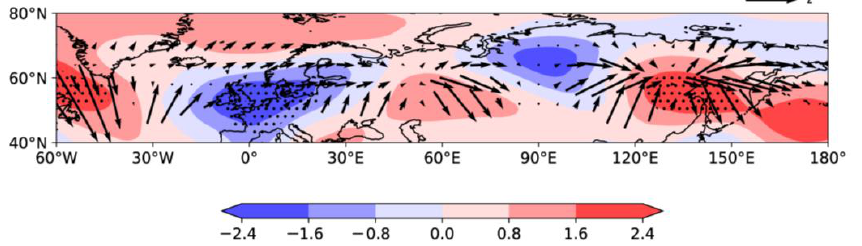
Figure 12. Composite summer geopotential height at 200 hPa (shading, units: dagpm) and Plumb wave activity fluxes (vector, units: m 2 ·s −2 ) for positive TSI cases. The 200 hPa geopotential height significant at the 90% confidence level are